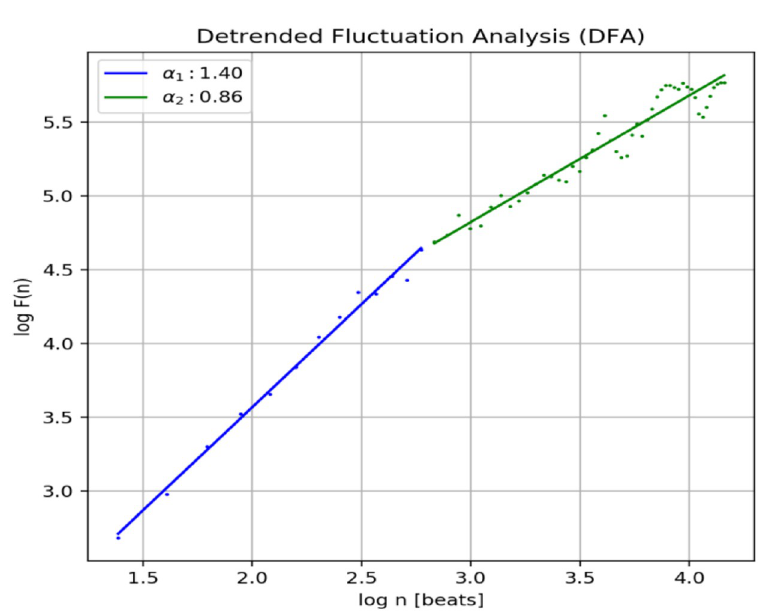
Fig 11. Detrended Fluctuation Analysis (DFA).